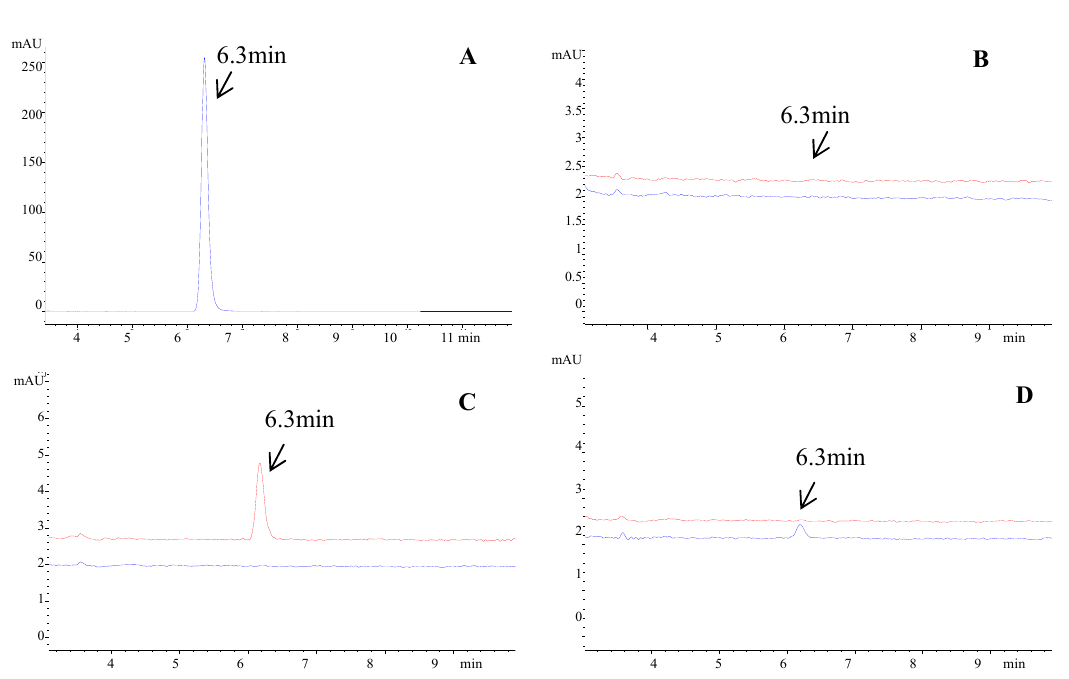
Figure 1. HPLC chromatogram of bifendate and detection of bifendate after extraction by hepatocytes. ( A ) Bifendate. ( B ) Final washing eluate (lower line) and desorption eluate (upper line) of the control group. There was no detectable bifendate at 6.3 min in the eluate. ( C ) Final washing eluate (lower line) and desorption eluate (upper line) of the medicated group. No detectable bifendate at 6.3 min was found in the final washing eluate. Bifendate was detected at 6.3 min in the desorption eluate which indicated that bifendate could bind to hepatocytes. ( D ) Washing eluate after four washes (lower line) and eight washes (upper line). Bifendate was detected after four washes while it was almost eliminated after eight